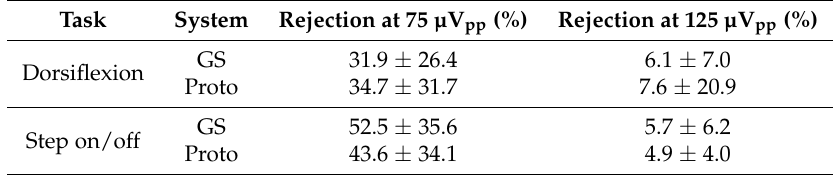
Table 1. Means and standard deviations for percentage epoch rejection rates at 75 µV pp and 125 µV pp .